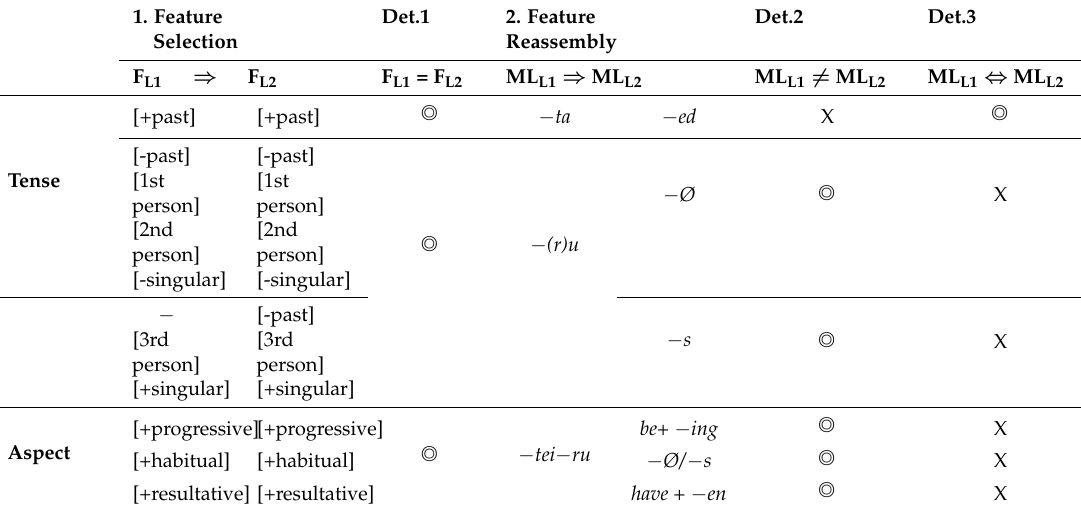
Table 3. L2 learning tasks and determinants of L2 learnability.